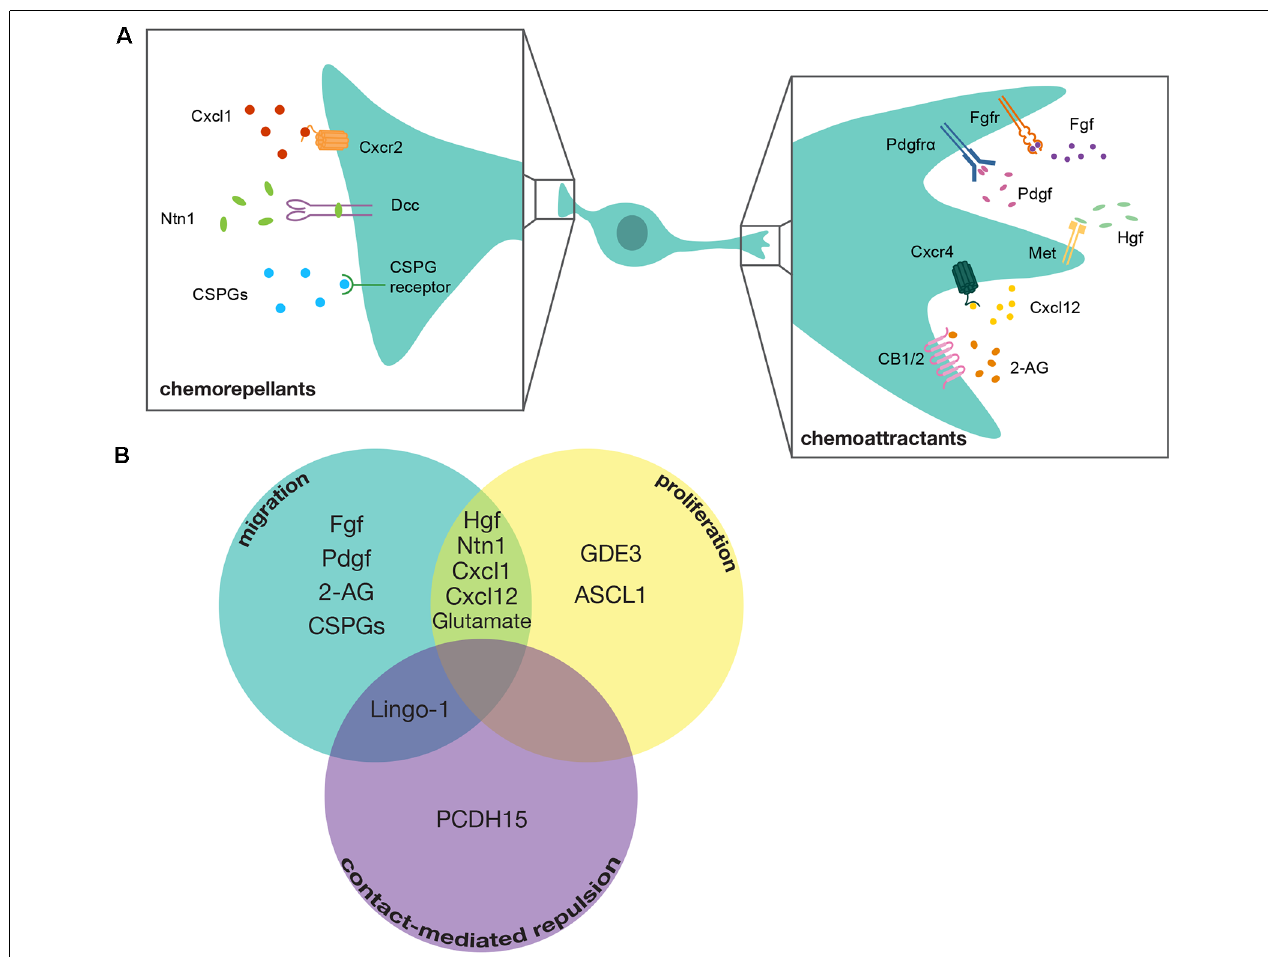
FIGURE 2 | Mediators of OPC tiling. (A) Diagram of a developing OPC in the spinal cord with chemotactic signaling molecules that guide either chemorepellent or chemoattractant migration. Chemoattractants include: Fibroblast growth factor (Fgf) signaling through its receptor Fibroblast growth factor receptor (Fgfr), Platelet-derived growth factor (Pdgf) signaling through its receptor Platelet-derived growth factor receptor alpha (Pdgfr α ), Hepatocyte growth factor (Hgf) signaling through its receptor Mesenchymal-epithelial transition (Met), C-x-c motif chemokine ligand 12 (Cxcl12) signaling through its receptor C-x-c chemokine receptor 4 (Cxcr4), and 2-Arachidonoylgylcerol (2-AG) signaling through its receptors Cannabinoid receptor type 1 and type 2 (CB1/2). Chemorepellents include: C-x-c motif chemokine ligand 1 (Cxcl1) signaling through its receptor C-x-c motif chemokine receptor 2 (Cxcr2), Netrin-1 (Ntn1) signaling through its receptor Deleted in colorectal carcinoma (Dcc), and Chondroitin Sulfate Proteoglycans (CSPGs) signaling through their cognate receptors. A cocktail of various CSPGs was used in this study, making it unclear exactly which CSPGs mediate this process. (B) Venn-Diagram demonstrating mediators that contribute to multiple tiling processes. GDE3, Glycerophosphodiester phosphodiesterase 3; ASCL1, Achaete-Scute Family BHLH Transcription Factor 1; Lingo1, Leucine-Rich Repeat and Immunoglobulin-like Domain Containing Nogo Receptor-Interacting Protein 1; PCDH15, Protocadherin Related